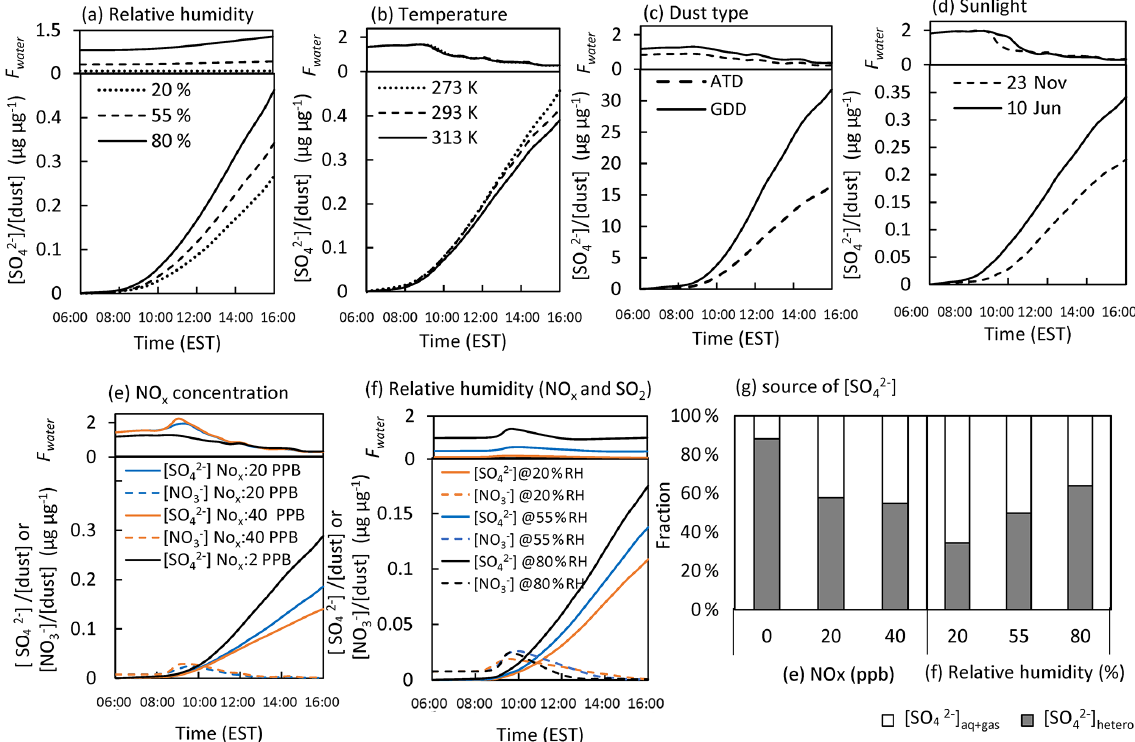
Figure 6. Sensitivity of the model predicted sulfate concentration to the (a) relative humidity at 20%, 55%, and 80%; (b) temperature at 273, 293, and 313K; (c) dust type (ATD vs. GDD); (d) sunlight profile (23 November 2017 vs. 10 June 2017); (e) initial concentration of NO x (2, 20, and 40ppb); and (f) relative humidity (20%, 55%, and 80%) in the presence of 20ppb of NO x . The fraction of sulfate from the gas phase and non-dust aqueous phase ([SO 2 − ] aq + gas ) and the heterogeneously formed sulfate in the dust phase ([SO 2 − ] hetero ) relative to the total 4 4 sulfate is shown in (g) . The dust-phase nitrate and water content were also predicted. For the sensitivity test, the simulation was conducted with 100µgm − 3 of initial GDD particles, 40ppb of initial SO 2 , 2ppb of initial O 3 , and 10ppb of isoprene under ambient environmental conditions on 23 November 2017. The simulation was performed without considering particle